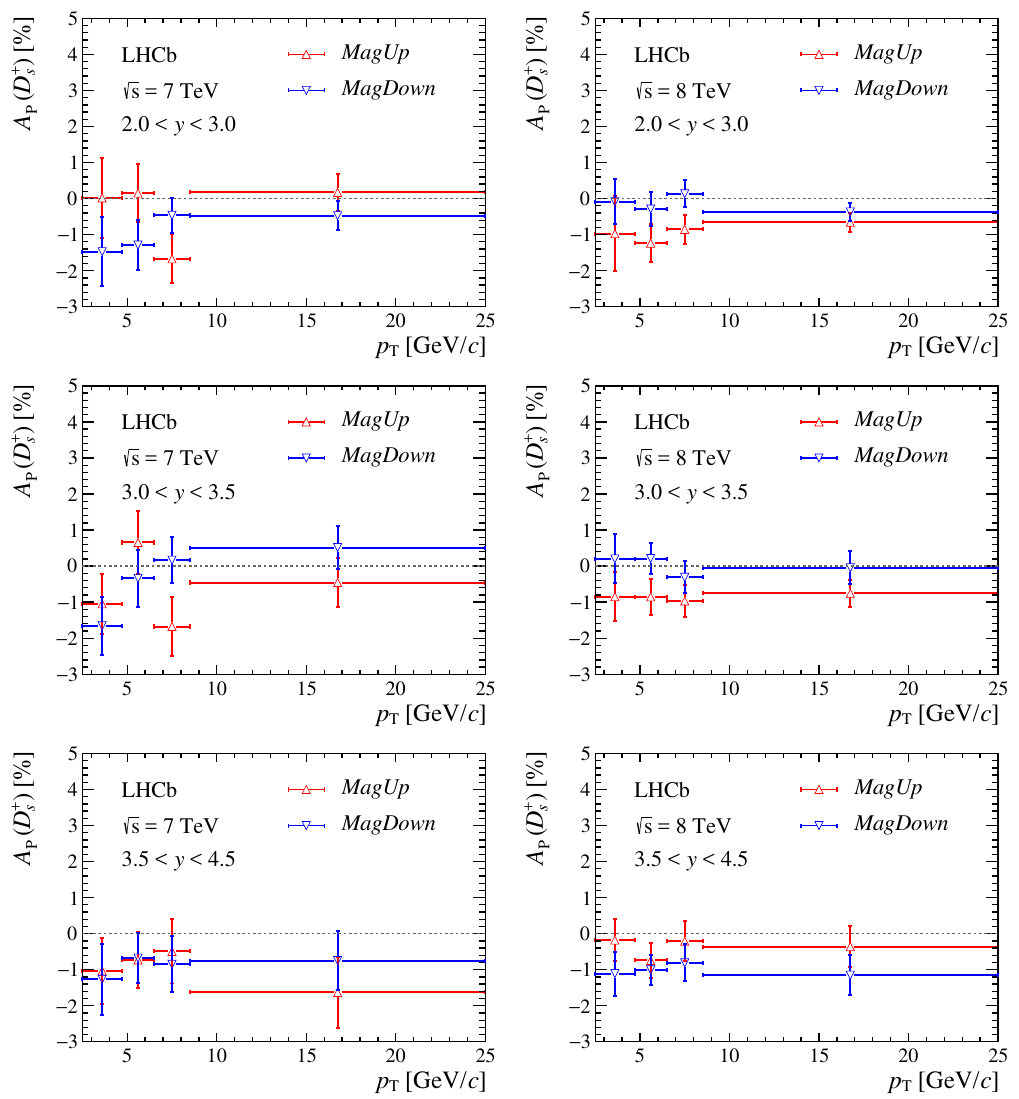
p s = 8 TeV data set.